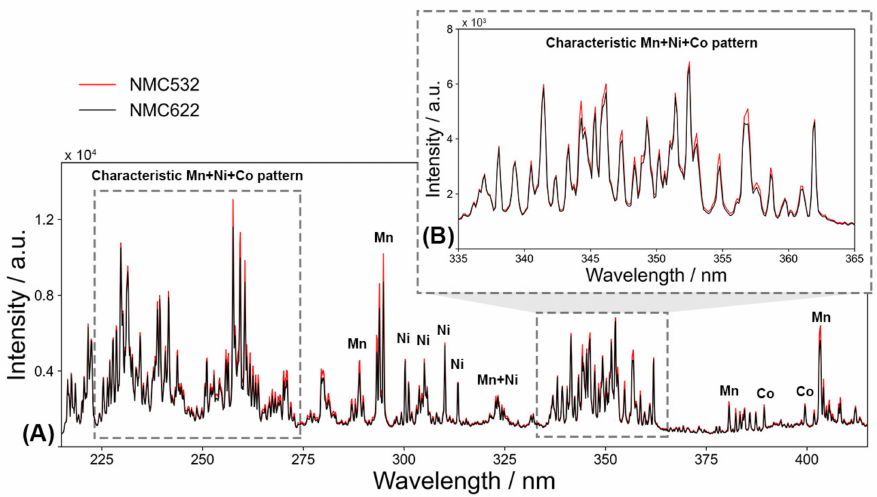
Figure 3. LIBS mean spectra of NMC532 and NMC622 between: ( A ) 215 and 415 nm and ( B ) 335 and 365